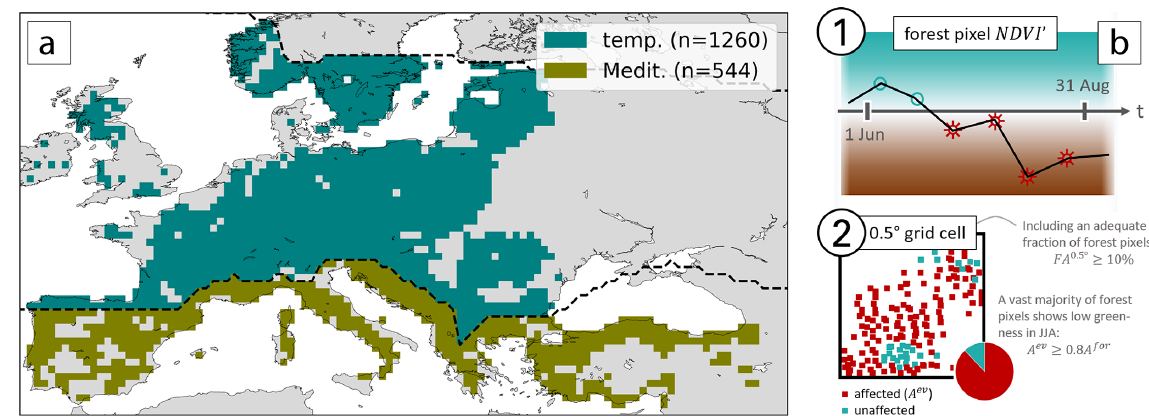
Figure 1. (a) Forest grid cells (FA 0 . 5 ≥ 10%) in the study domain, separated into temperate and Mediterranean forests by the dashed black line. The boreal biome is cropped by the second dashed line in the northeast of the domain. (b) An example of the identification of low-NDVI grid cells, where (1) forest pixels are flagged if at least four out of six time steps show negative NDVI (cid:48) , and (2) 0 . 5 ◦ × 0 . 5 ◦ forest grid cells are flagged if more than 80% of the forest pixels within are flagged (details provided in the text).